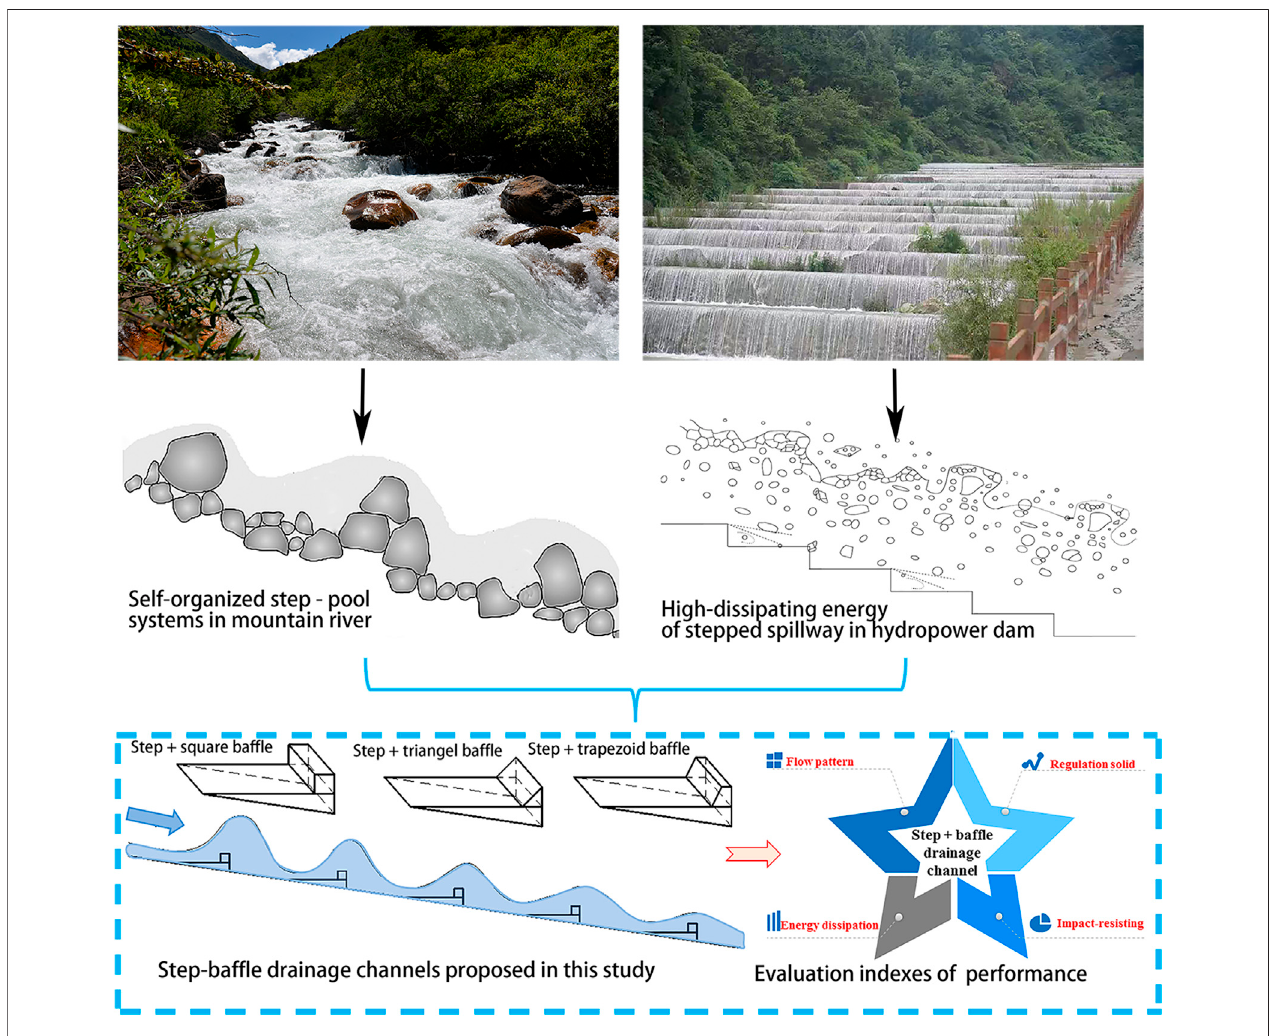
FIGURE 2 | Overview of the inspiration for the present topic.